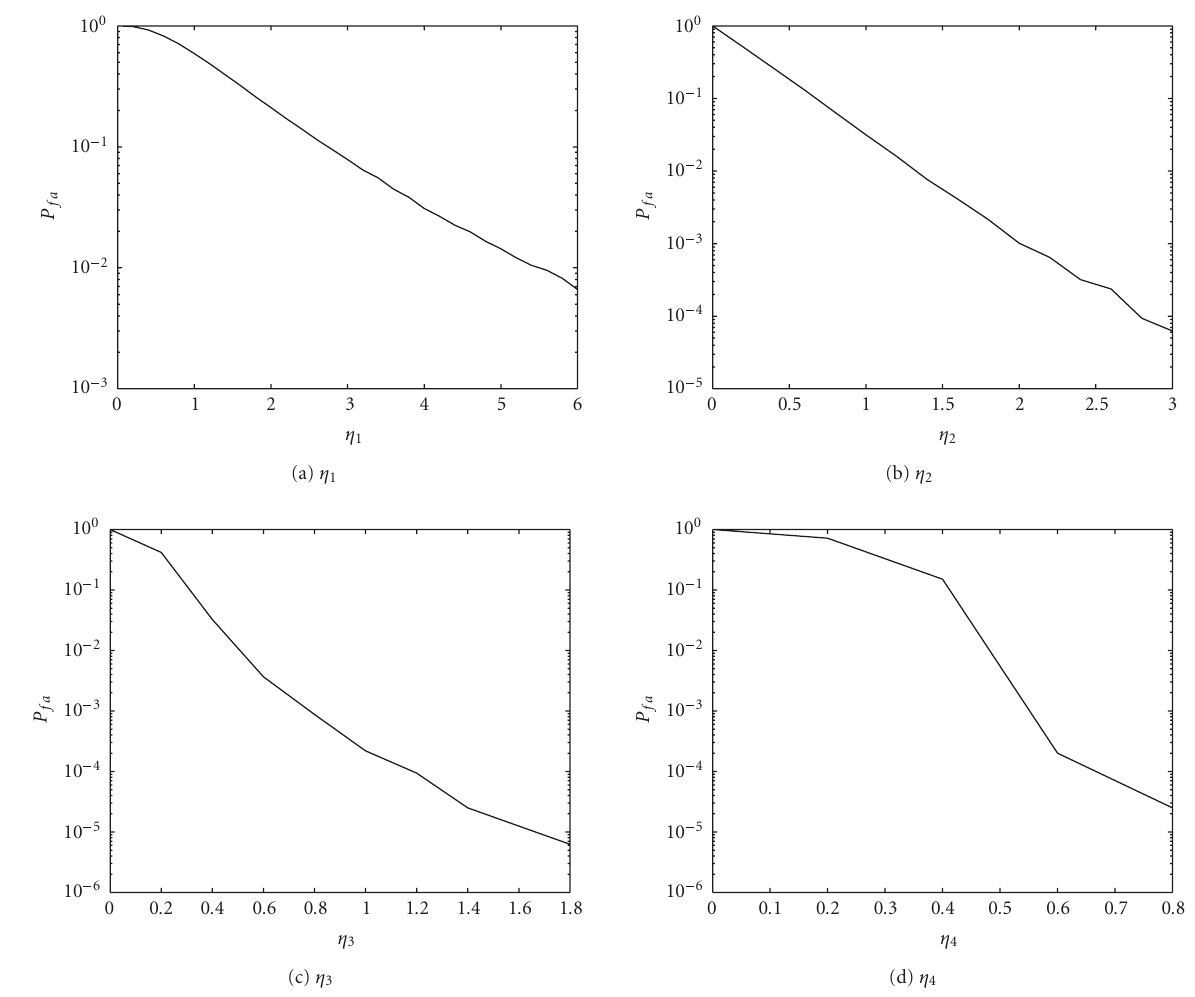
Figure 3: Thresholds computation for M = 5 and N =